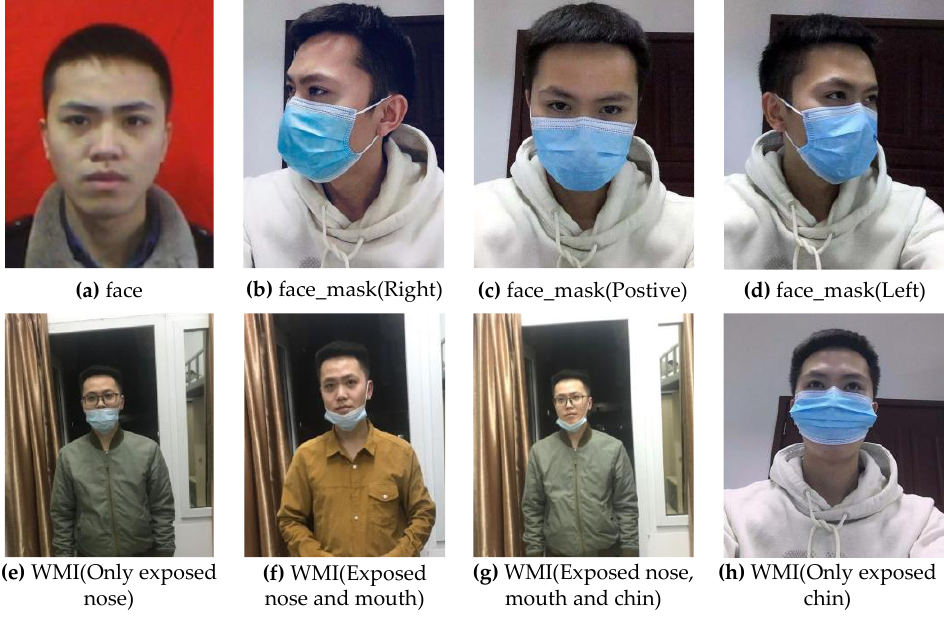
Figure 11. Sample diagram from the data set.